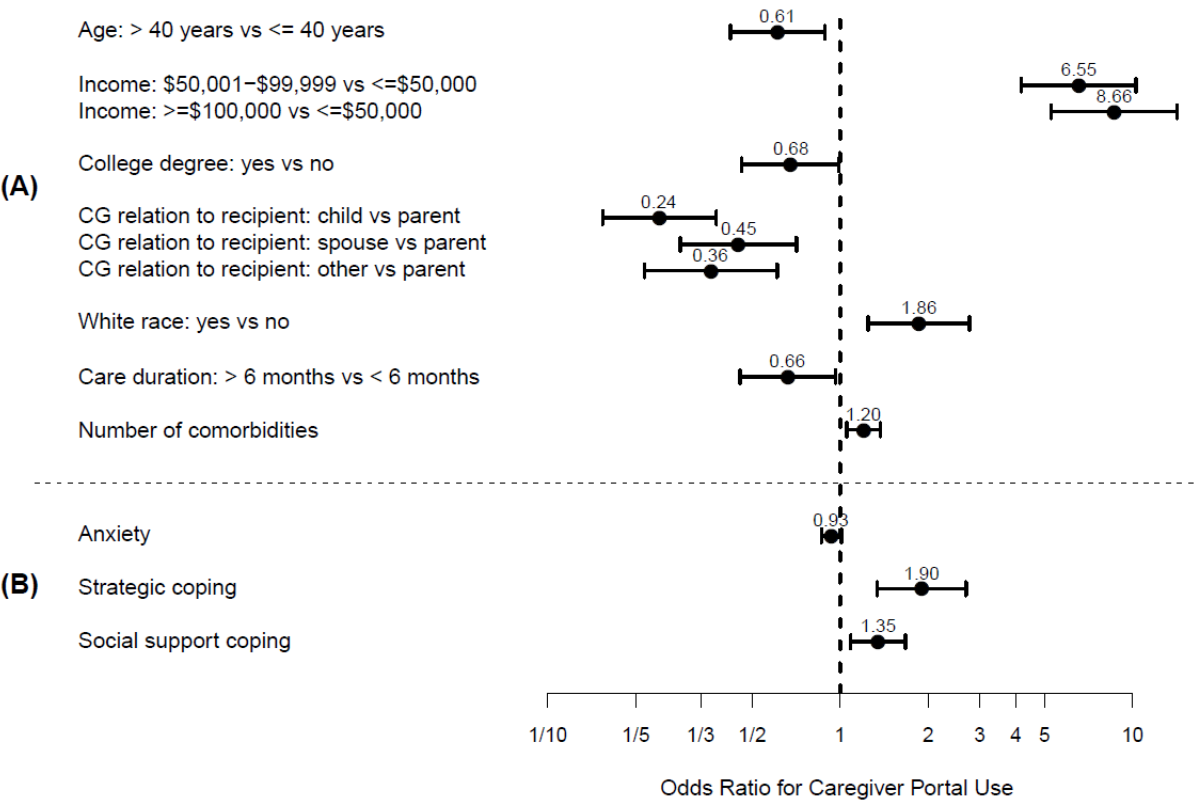
Figure 5. Multivariate odds ratios (dots) and 95% confidence intervals (bars) for (A) caregiver characteristics and (B) mental health for the use of a caregiver’s own health